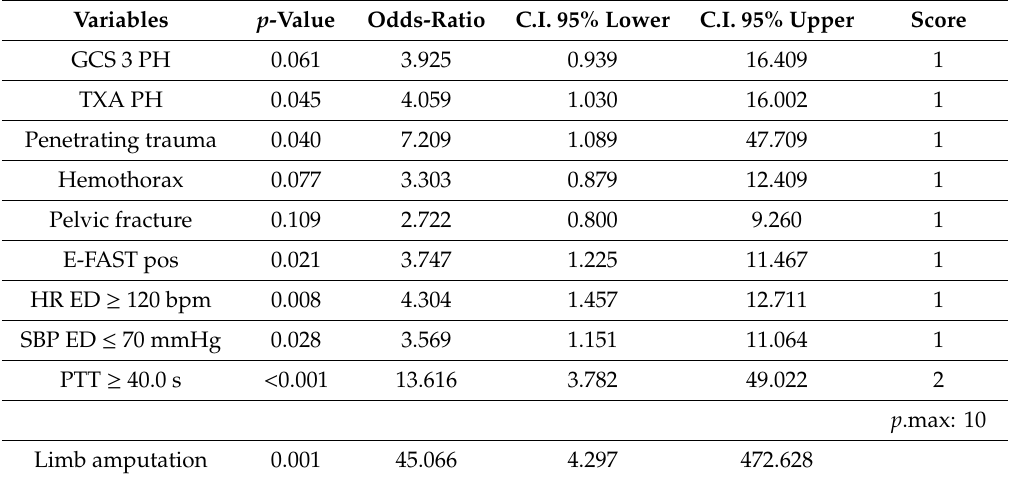
Table 3. Independent predictors of MT with multivariate analysis from Milano Trauma Registry.